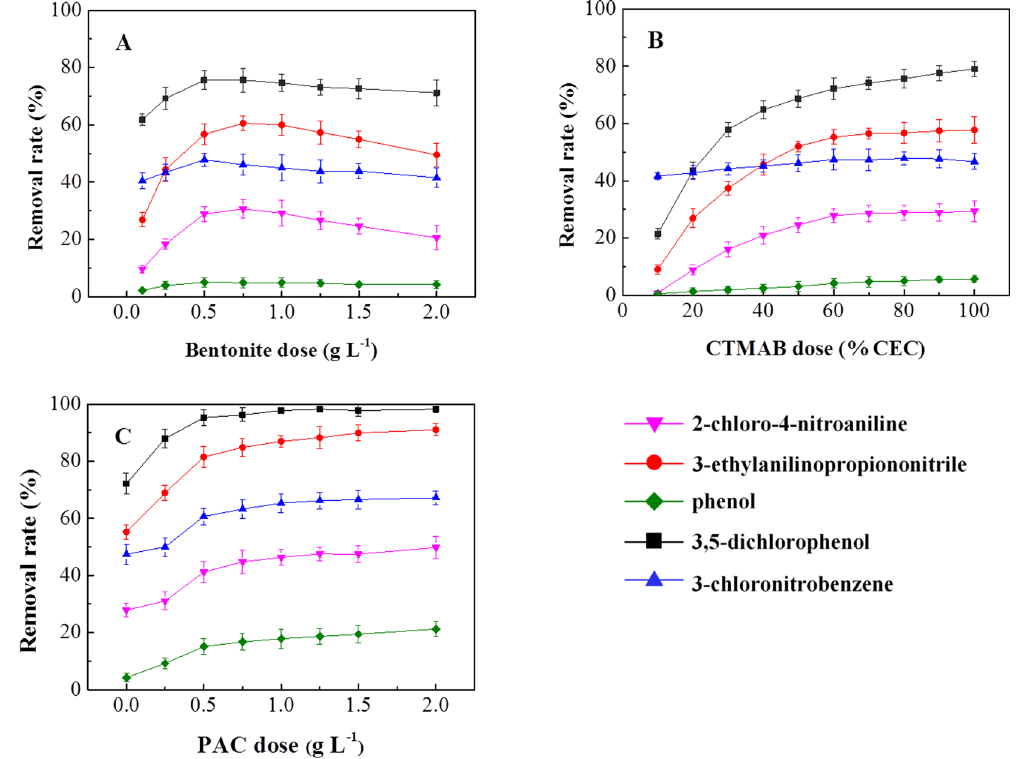
Figure 1. Dose effects of bentonite, CTMAB and PAC on the removal rates of selected organic pollutants. ( A ) CTMAB dose is fixed at 100 mg L − 1 , ( B ) bentonite dose is fixed at 0.5 g L − 1 , ( C ) bentonite and CTMAB dose is fixed at 0.5 g L − 1 and 60% cation exchange capacity, respectively. Error bars represent standard deviations ( n =